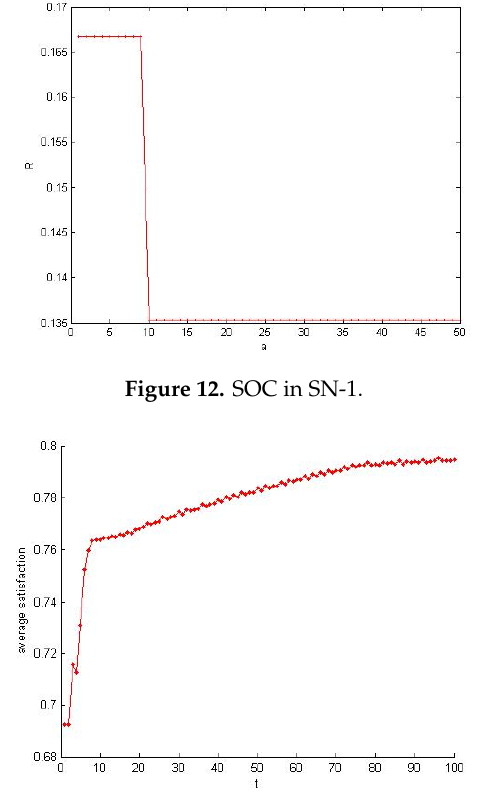
Figure 13. Satisfaction increased in the self-organization evolution.